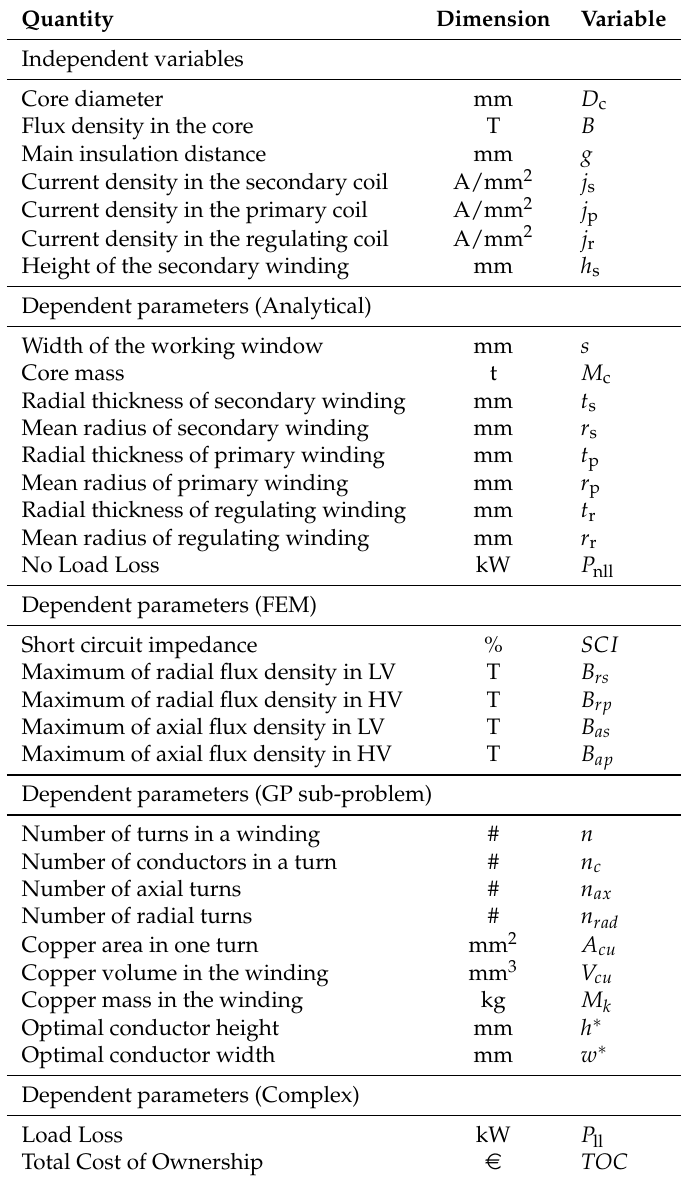
Table 1. The parameters of the optimized active part